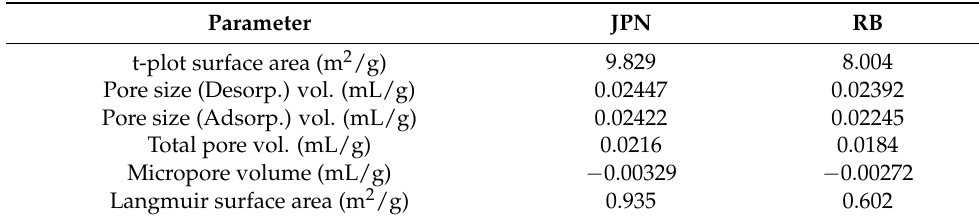
Table 4. Surface area and pore volume analyses of JPN and RB